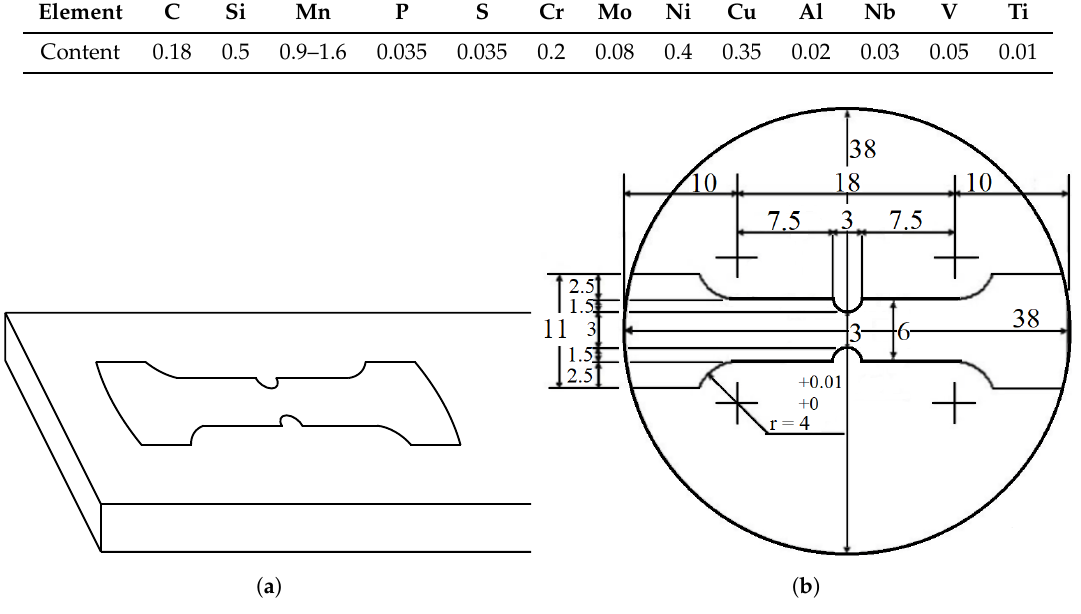
Figure 2. ( a ) This figure shows how the specimens are taken from the NVE36 plate. The plate and specimen are not in scale. ( b ) The notched specimen geometry used for in situ SEM tensile tests. All measurements are in